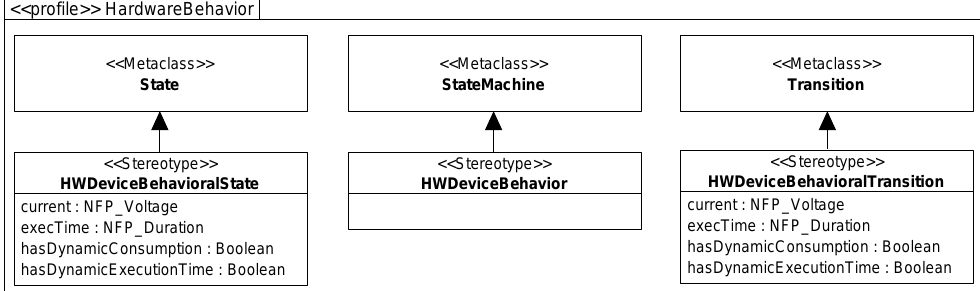
Figure 11. PAP HardwareBehavior sub-profile package, adapted from [15] (UML 2.5 profile diagram